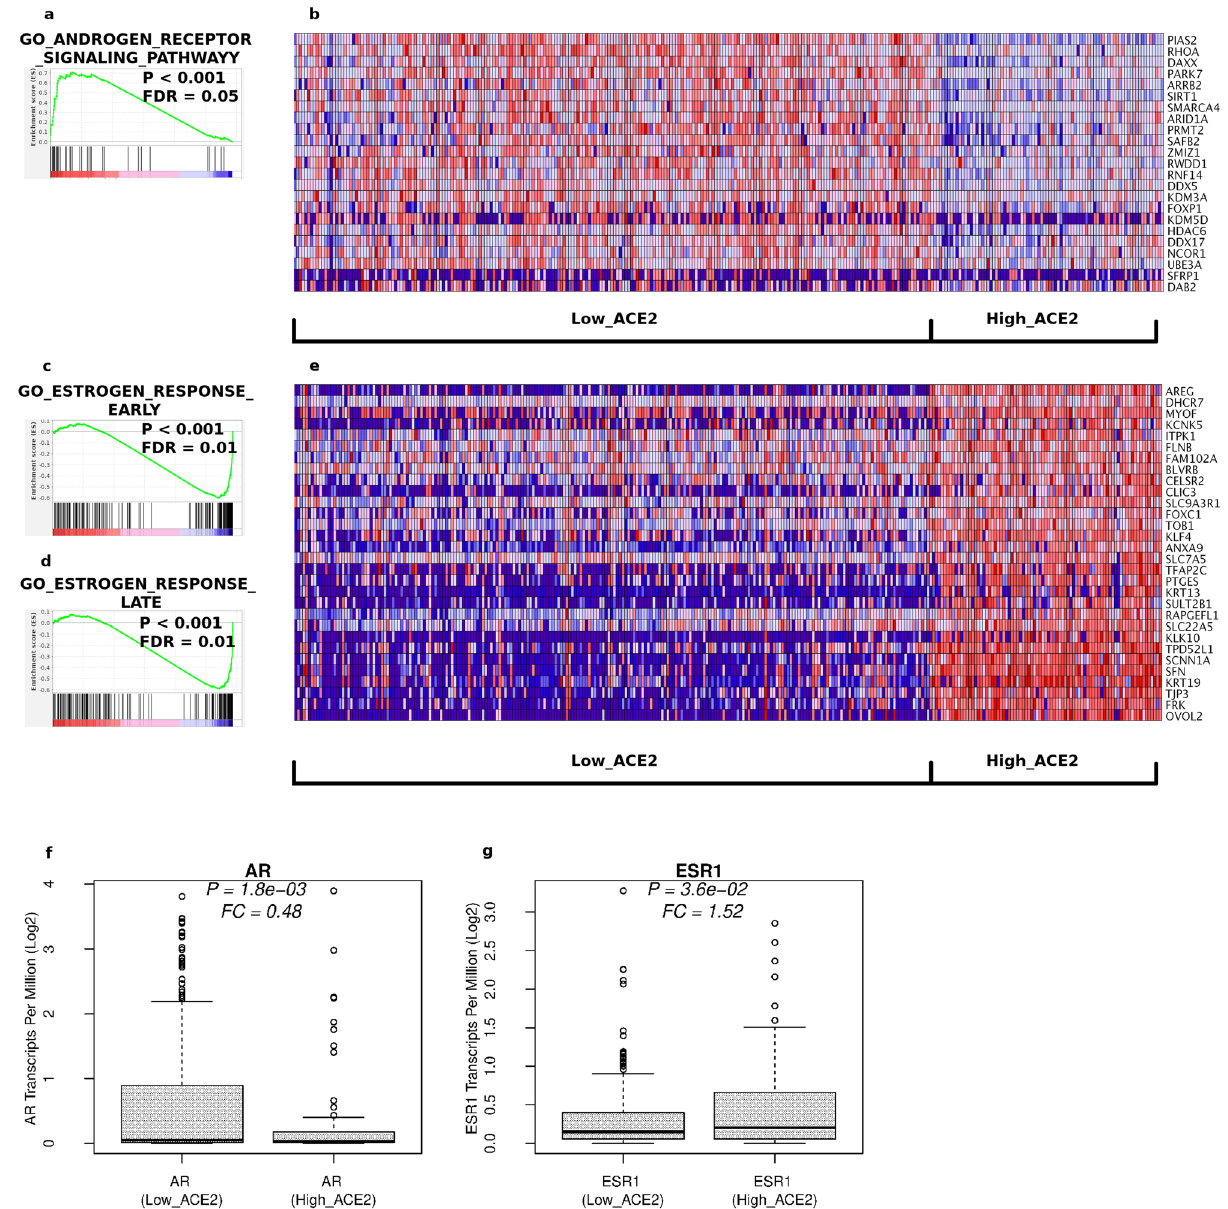
Figure 4. Hypogonadism and estrogen response is coupled to ACE2 overexpression in male cell lines. GSEA in male cell lines identifies a downregulation of the androgen receptor signaling pathway ( a , b ), coupled to un upregulation of the estrogen response ( c – e ) and to the transcriptional downregulation of the androgen receptor ( f ) and to the transcriptional activation of the estrogen receptor ( g related to ACE2 expression in normal and tumor tissues from lung and other organs in GTEx 62 and in The Cancer Genome Atlas (TCGA) 10,16 . While advantages of using in-vivo vs. ex-vivo material are quite obvious, the present approach also has some strengths. For example, the stromal component of a tumor tissue can have a confounding effect on the measurement of gene expression, leading to mixed results. Conversely, in our study, besides using clonal cell lines, a robust filtering was made in order to consistently separate low- vs. high-express- ing samples, even at the cost of removing more than half of the cell lines from the analysis (Fig. 1a). Despite these differences, there were some overlaps between the findings of the two analyses, since both analyses found that highly expressing ACE2 cells or tissues were susceptible to an inflammatory response, with in-vivo studies also showing that the increased inflammatory signaling was related to higher ACE2 expression in smokers 16 . On the other hand, our model also showed that an eicosanoid storm was likely involved in the ongoing inflammatory response.